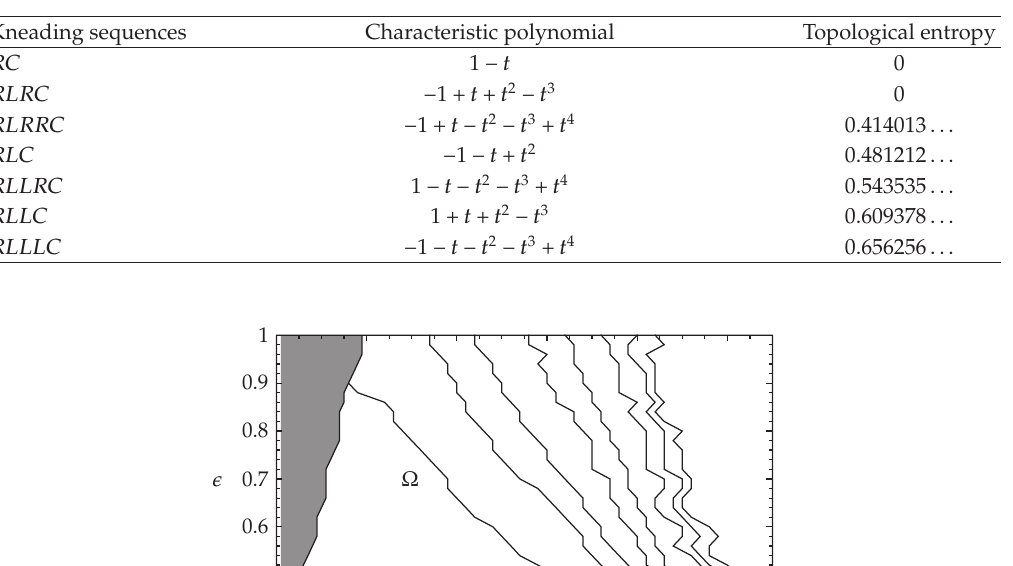
∞ , 5-period— (cid:3) RLRRC (cid:4) ∞ , and 5-period— (cid:3) RLLLC (cid:4)